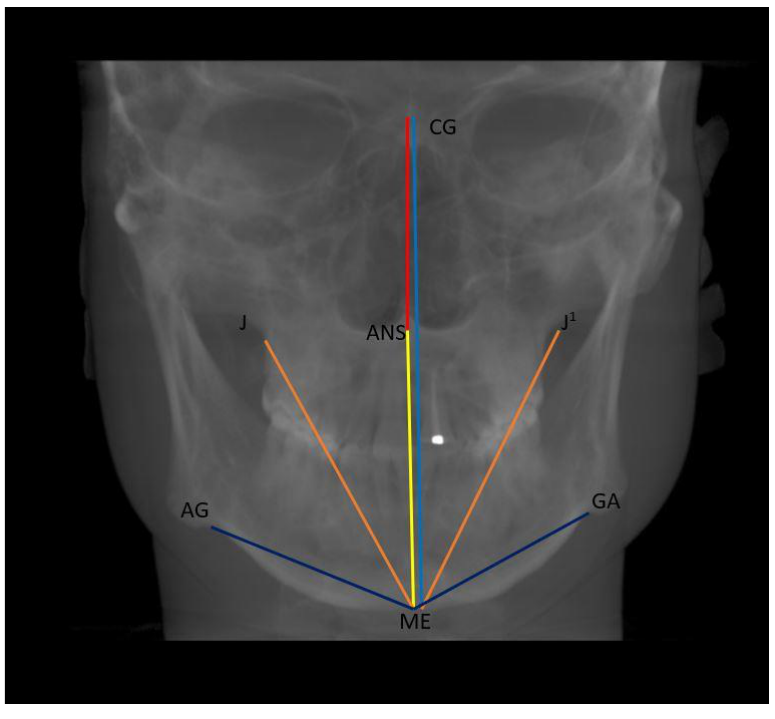
Figure 5. Vertical measurements of facial asymmetry. Finally, linear distances from left and right landmarks (AZ, C, J, and AG) to MSP, and differences in the vertical dimension of the perpendicular projections of bilateral landmarks to MSP were measured (Figure 6).